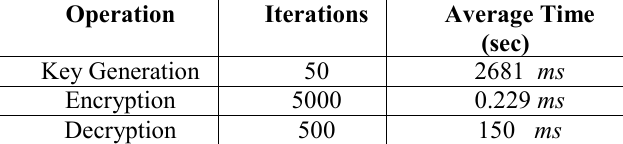
TABLE II. 3072 bit modulus RSA Computation